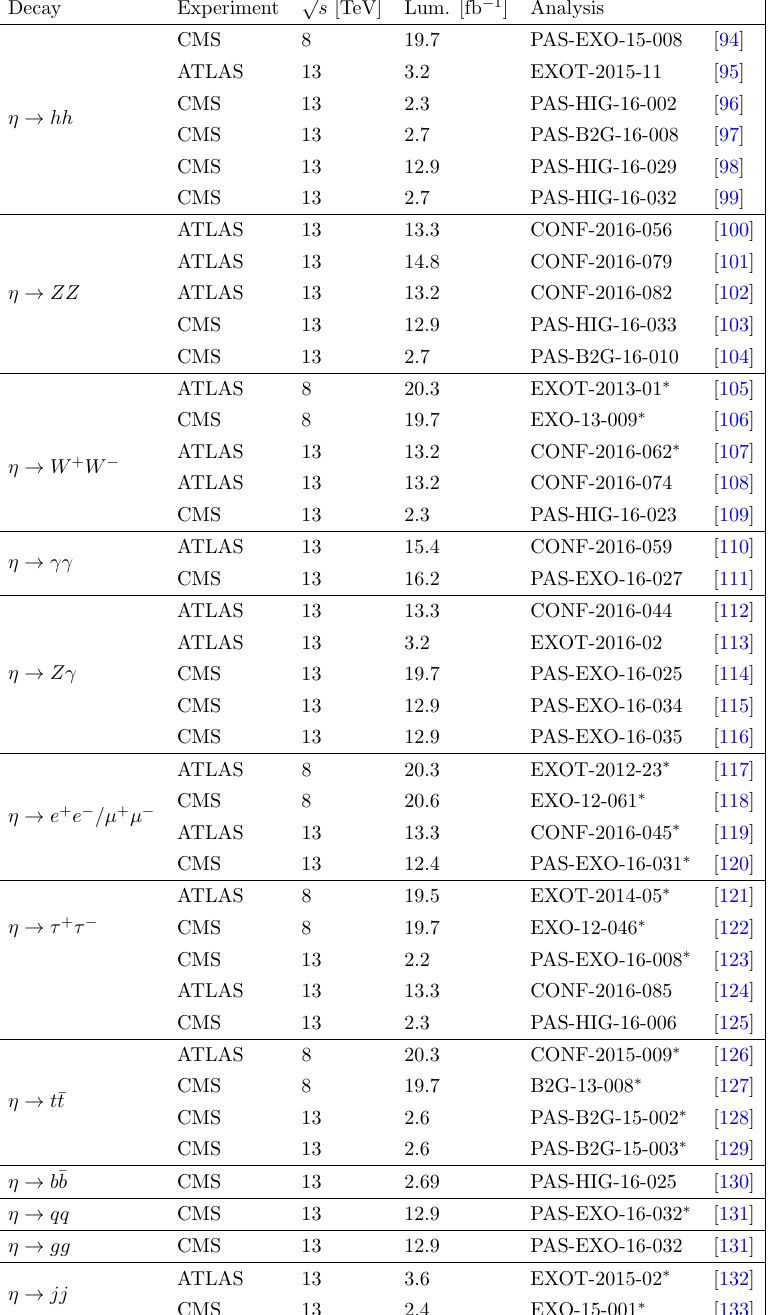
Table 2 . Experimental analyses included in our numerics for (cid:17) decay. The analyses marked with are actually searches for neutral vector resonances. Since for many channels there are no dedicated analyses searching for a neutral scalar resonance and the bounds should be similar, we include the spin-1 analyses in our numerics for (cid:17) decay.